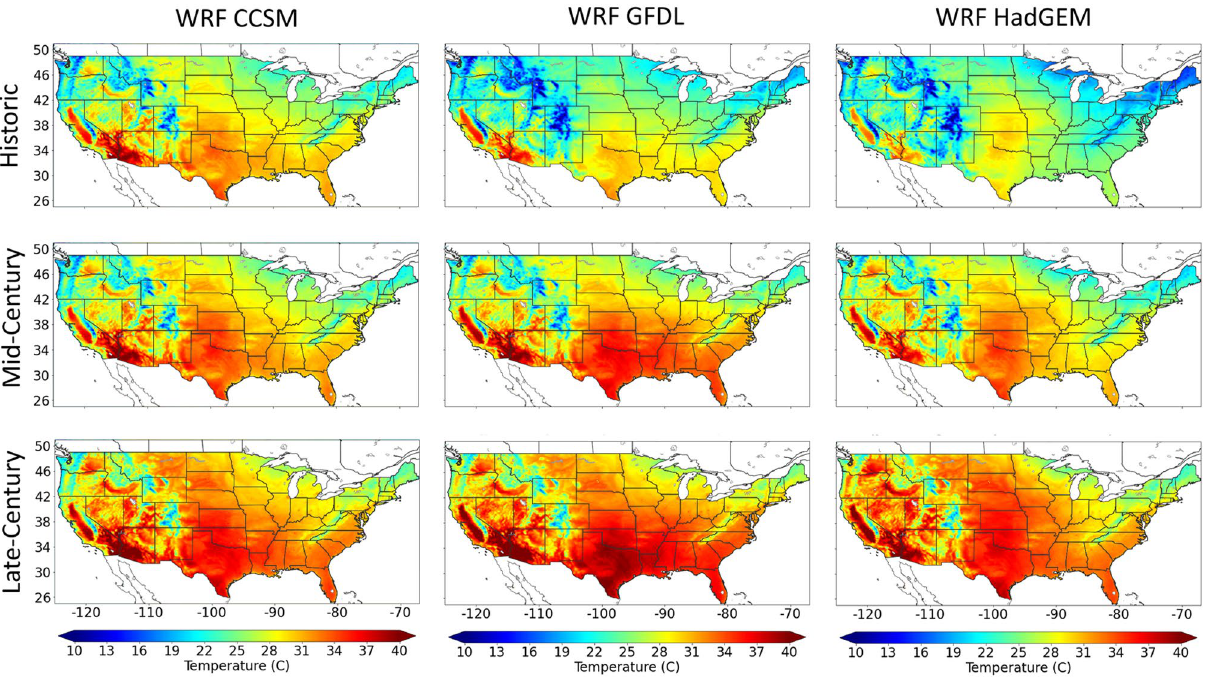
Figure 4. June, July, and August averaged daily maximum temperatures for each timeframe with WRF CCSM, WRF GFDL and WRF HadGEM. This figure was generated using the Matplotlib 41 library for the Python programming language (https:// matpl otlib. org/).